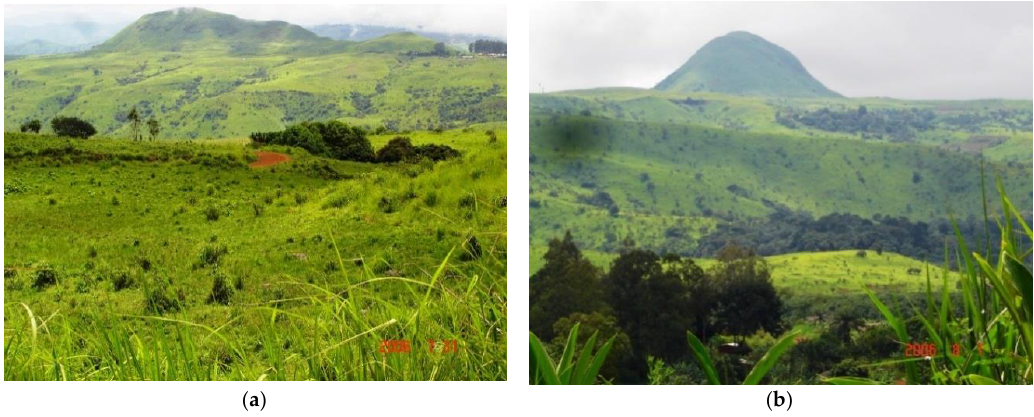
Figure 5. ( a , b ): The Nkambe basaltic plateau on the Ndu volcanic ridge. A stratovolcano eruptive cone at the left, and a volcanic dome overlooking the plateau at the right (August 2006).